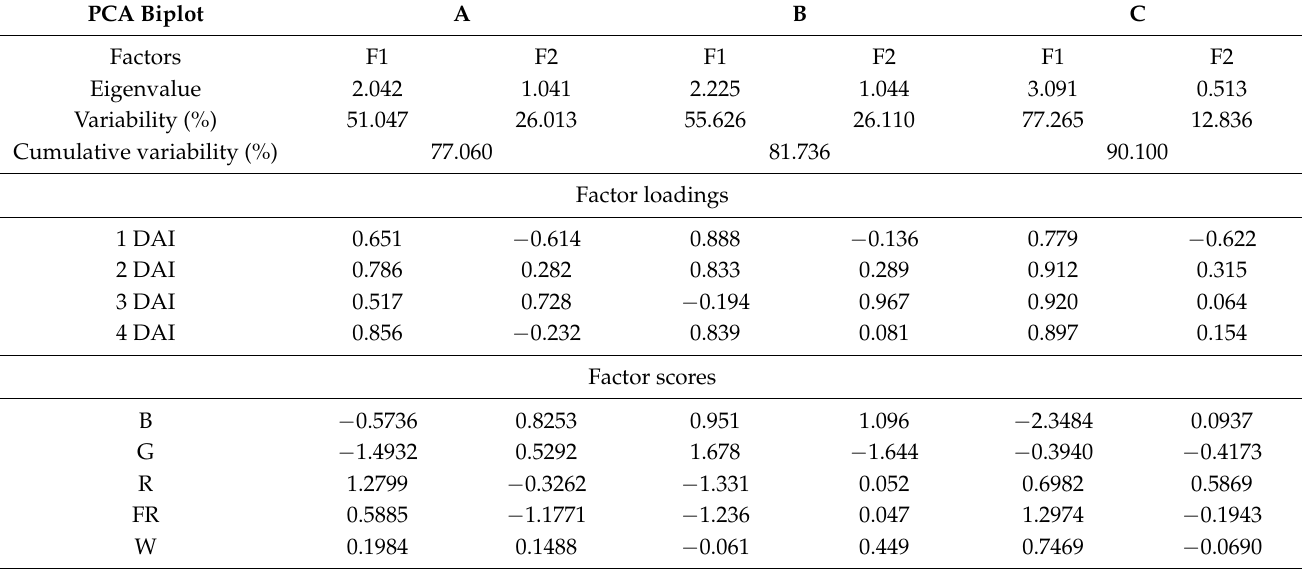
Table 1. Factor loadings, eigenvalues, variability (%), cumulative variability (%), and scores for the measurements under five different LED light wavelengths on first-four days after inoculation. The PCA Biplot A, B, C indicates treatments of 50, 100, and 200 µ mol m − 2 s − 1 photon flux density, respectively. DAI—days after inoculation; B—blue (peak = 450 nm); G—green (peak = 530